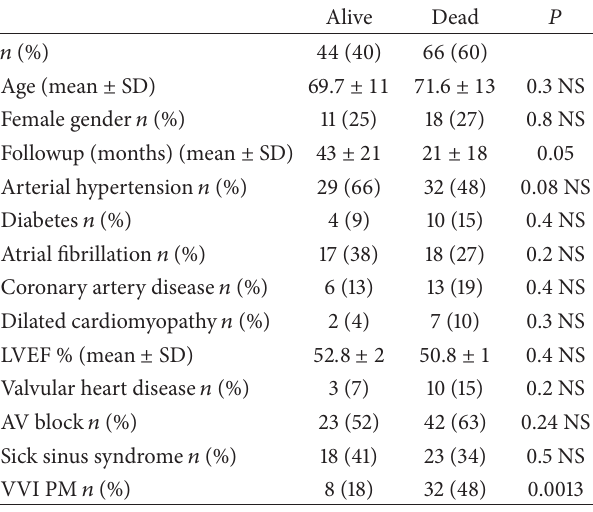
Table3:Characteristicsofthepropensity-matchedadjustedgroups.